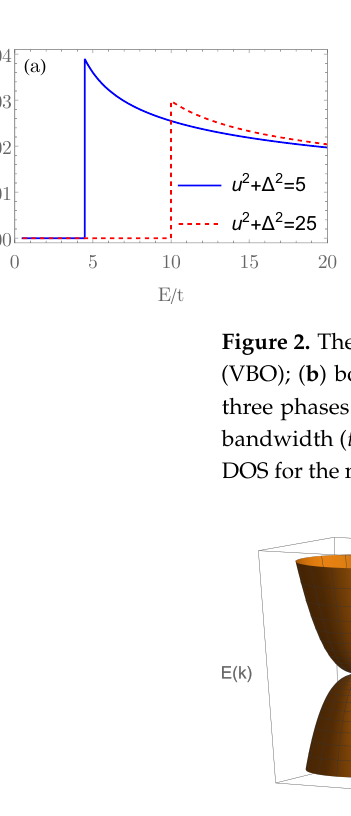
Figure 3. The band structure for the noninteracting Hamiltonian given by Equation (1) (left panel), where the pairs of degenerate bands corresponding to the same valley are superimposed. In the smectic charge-density wave with the order parameter Γ ρ 0 , ρ = 1,2, the two cubic band touching points split into six points, with the triplets featuring opposite vorticities ± π (right panel). Notice that the smectic charge-density wave order parameter mixes the two valleys and, therefore, also breaks the original lattice translation symmetry, besides the rotational one. The rotational symmetry is, however, restored close to each of the new band touching